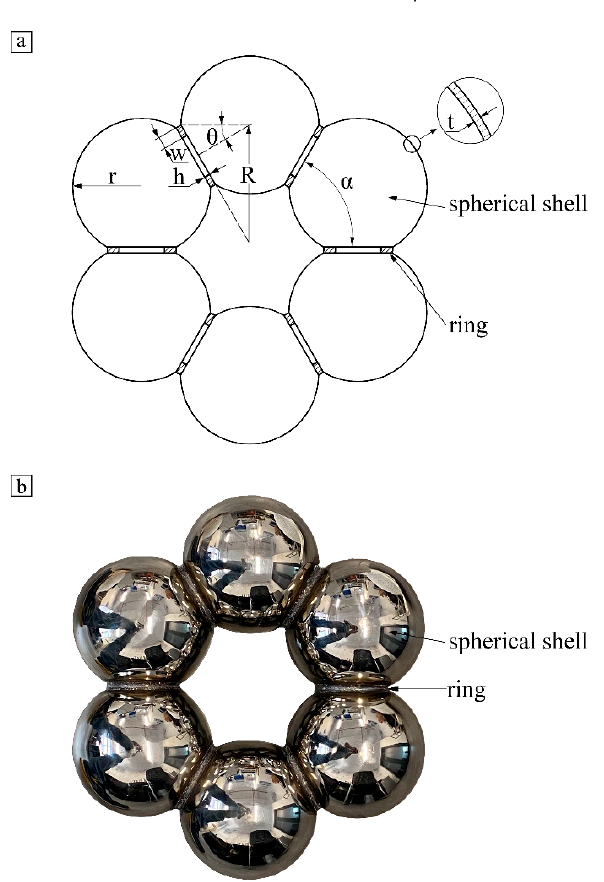
Figure 1. Geometric notations ( a ) and photograph ( b ) of a sphere-segmented toroidal shell.